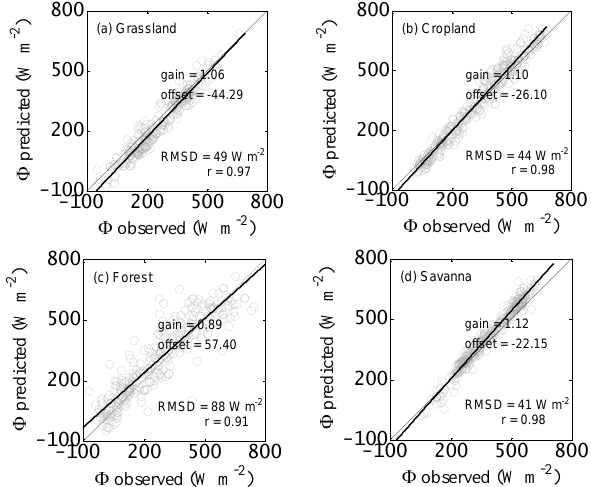
Figure 6. Validation of net available energy ( (cid:56) ) ( = λE + H ) using high-temporal-frequency (daily) observations of midday (13:30LT) and night (01:30LT) R N and T S (solving Eq. 10a and b) at the eddy covariance tower sites over four representative biomes.